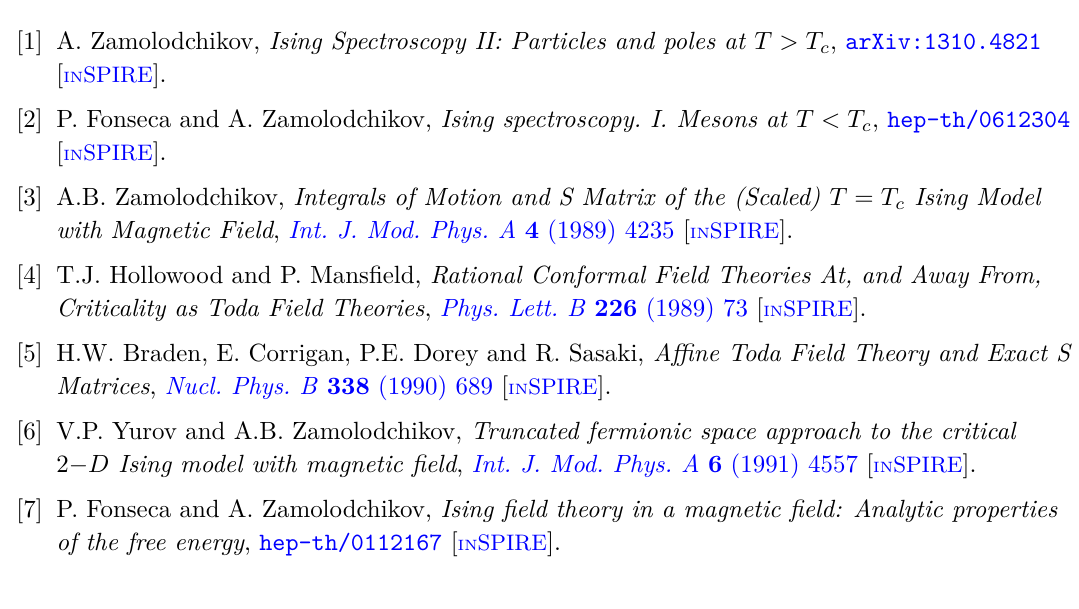
(in blue) and without z 0 (in x x